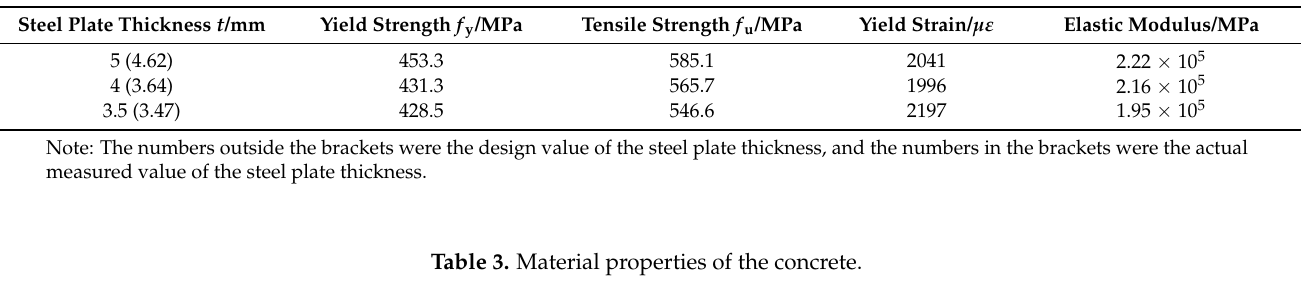
Table 2. Material properties of the steel plates.